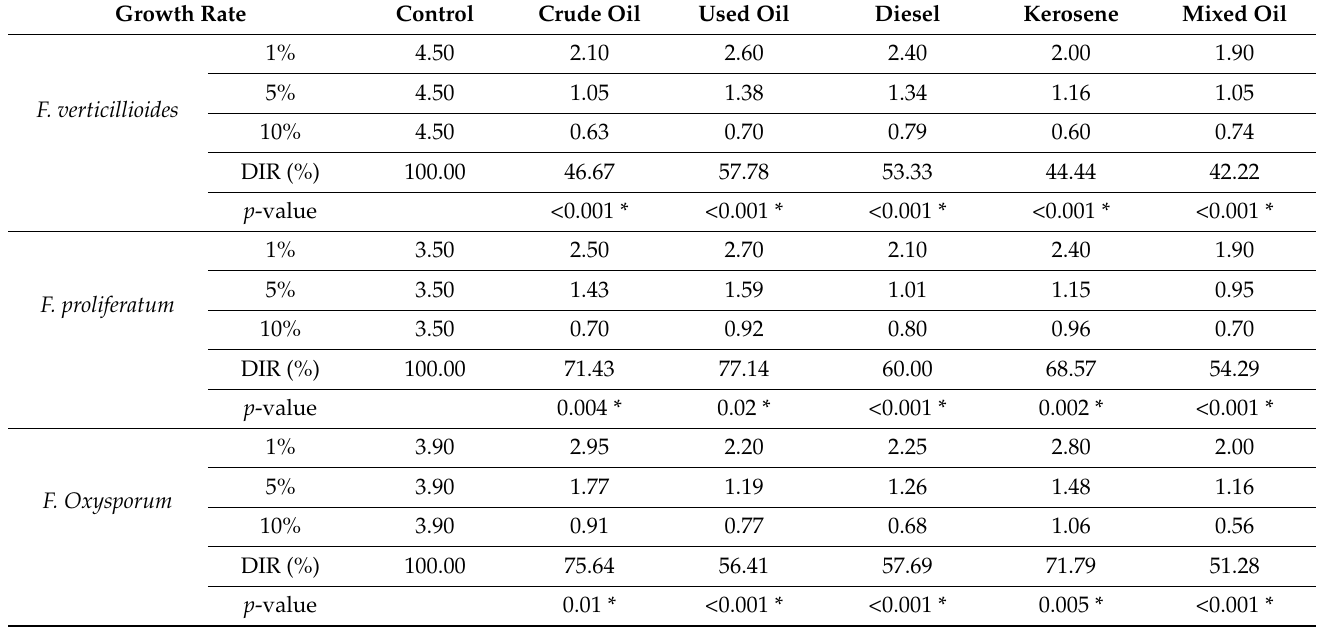
Table 2. The ability of isolated fungal strains to grow and tolerate different types of petroleum hydrocarbons. Growth Rate Control Crude Oil Used Oil Diesel Kerosene Mixed Oil